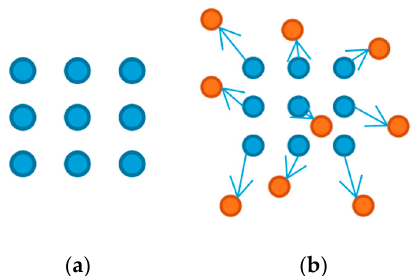
Figure 5. Comparison of conventional 3 × 3 convolution and deformable convolution. ( a ) Normal convolution; ( b ) deformable convolution.